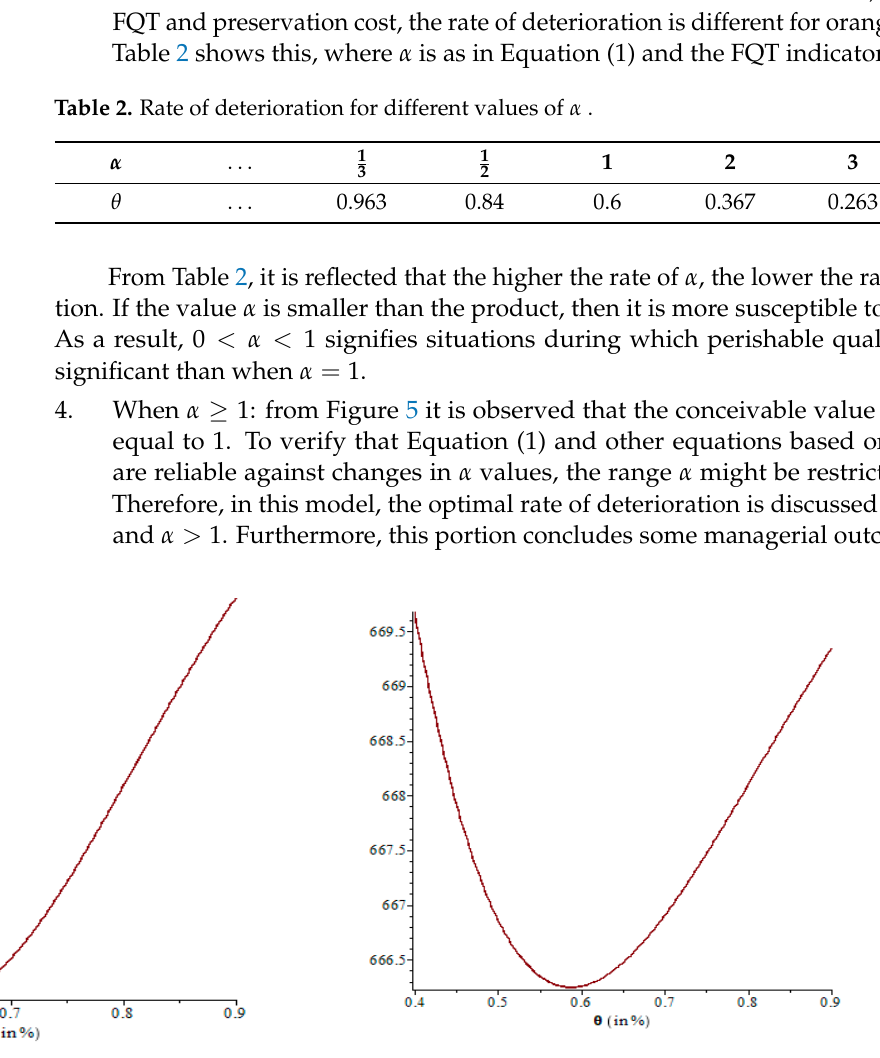
Figure 5. Optimal range of θ when α > 1 for Case (I) and Case θ α> when 1 for Case (I) and Case (II ).